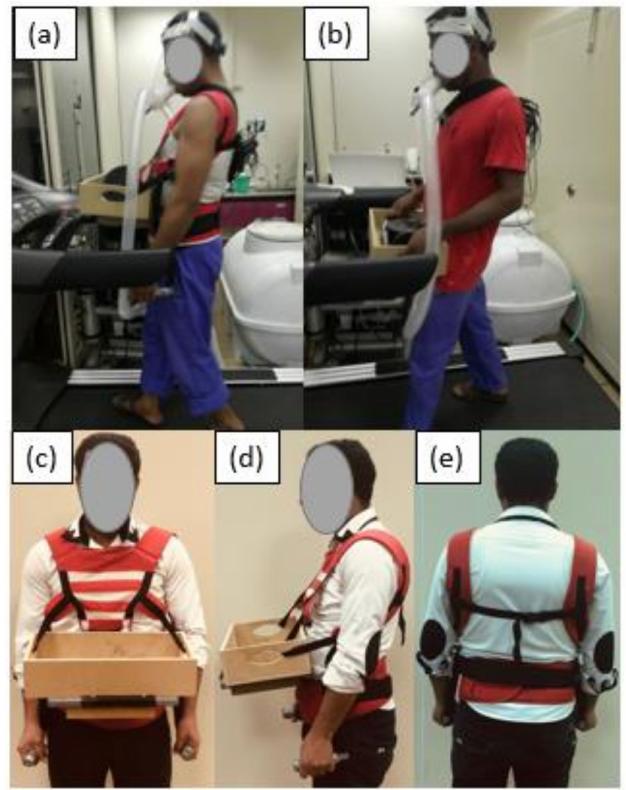
Figure 1. Pictures of the experimental setup. Pictures of a participant walking on the treadmill with and without wearing aid ( a , b ). Illustrative pictures of the aid ( c – e